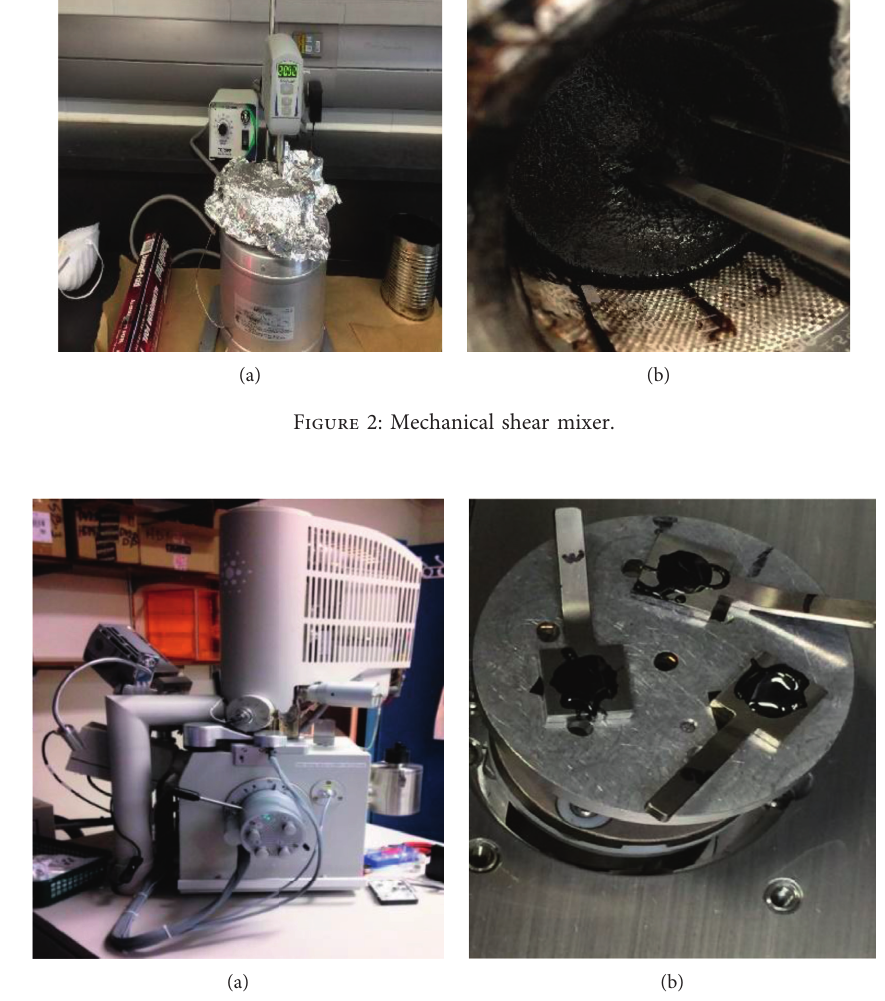
Figure 3: ESEM device (a) and sample mould with binder in the ESEM stage (b).